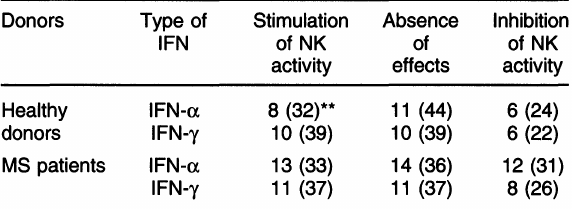
Table 2. Distribution of the in vitro effects of auto-IFNs on human PBL NK activity (number of observations)* Donors